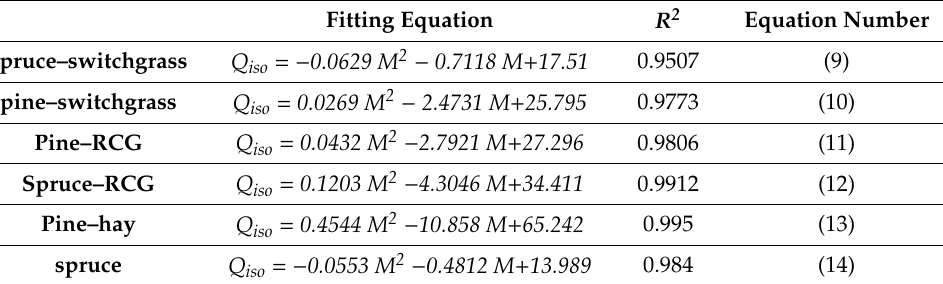
Table 4. Variation of the net isosteric heat of sorption as function of EMC. Fitting